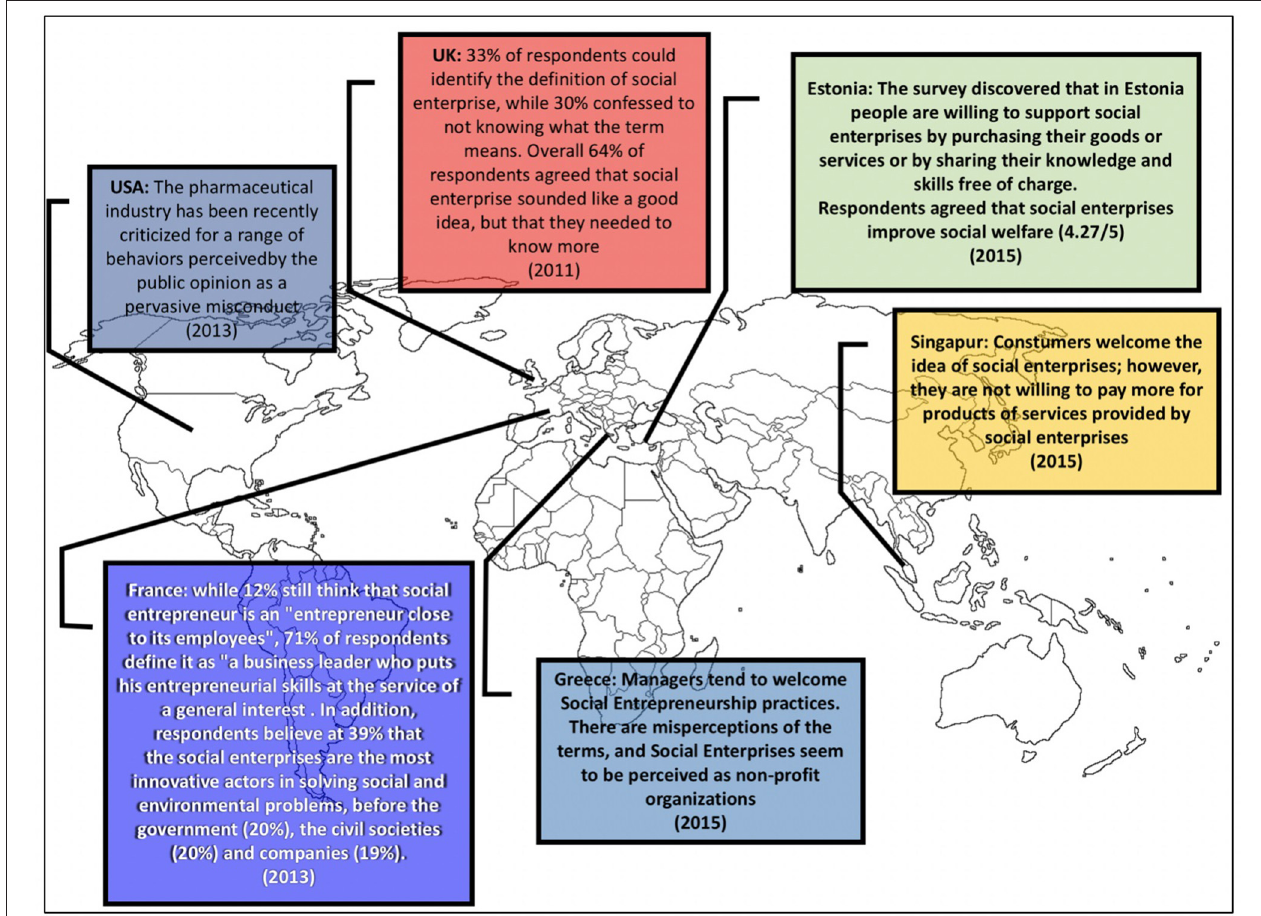
FIGURE 3 | Perceptions related to “social enterprises” in different